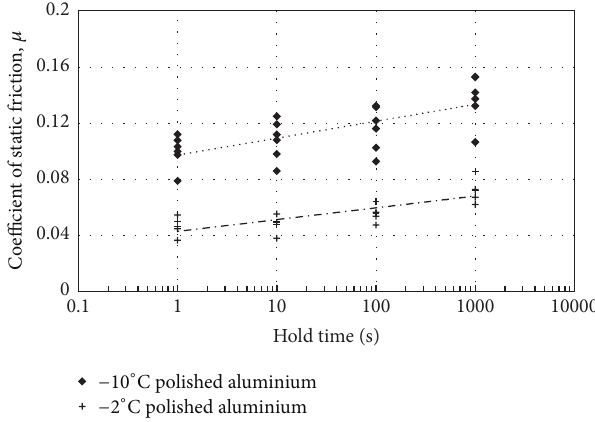
Figure 4: Friction as a function of hold time for experiments involving rough (crosses) and polished aluminium (triangles) at − 2 ∘ C.Individualdatapointsrepresentseparateexperiments,andthe lines represent logarithmic best fits.